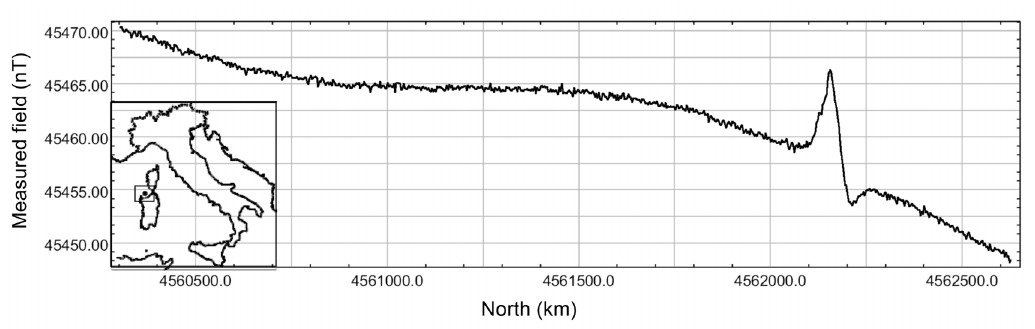
Fig. 7. Magnetic field along the significant profile recorded in the Asinara